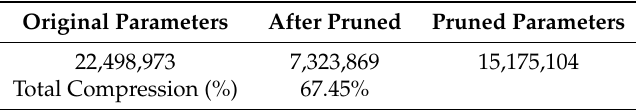
Table 6. Deep Convolutional Network Pruning